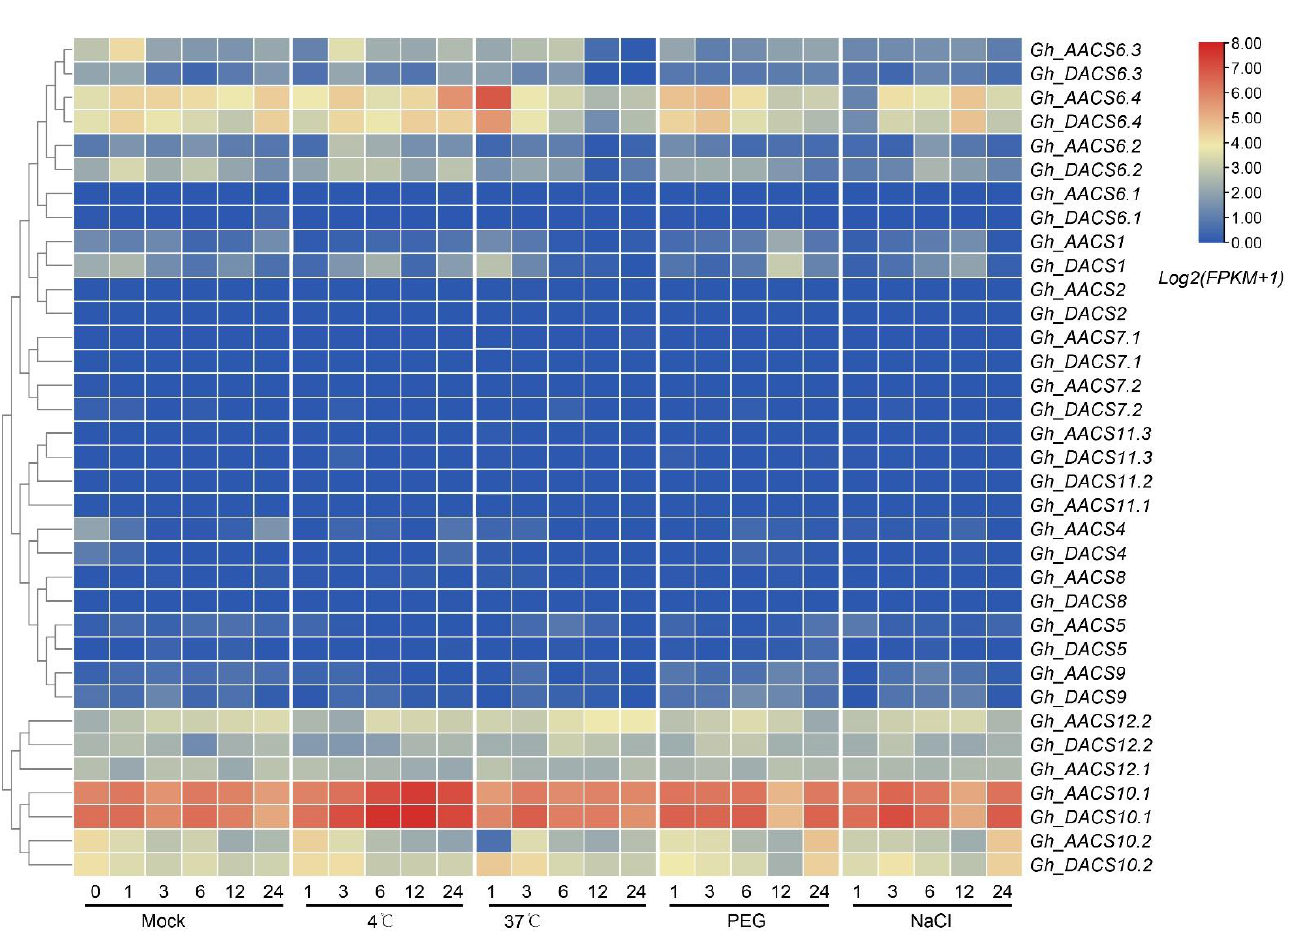
Figure 8. Expression patterns of the GhACS genes in response to abiotic stresses. The heatmap shows the expression changes of ACS genes in G . hirsutum under cold, hot, drought, and salt stress at different exposure times.